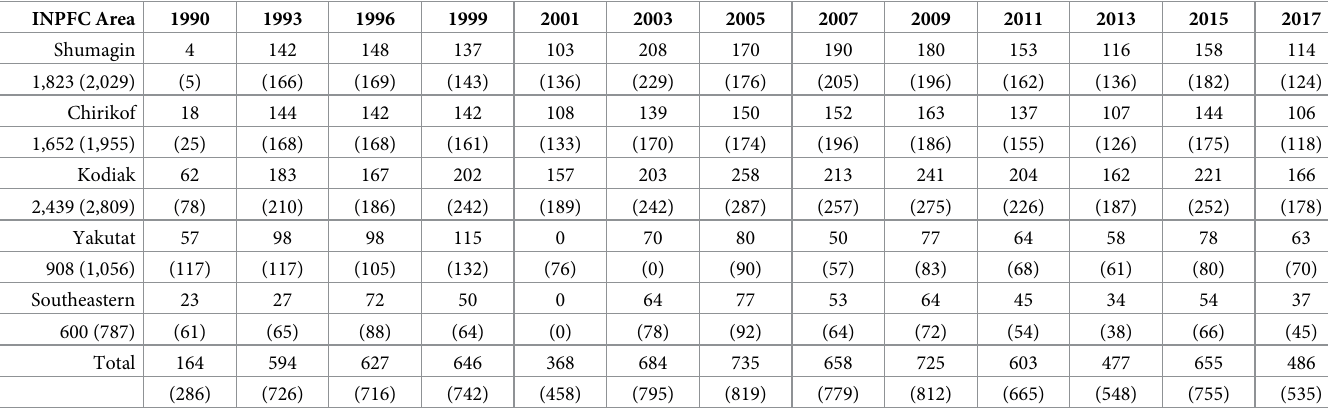
Table 2. Number of tows that captured at least one Arrowtooth Flounder (n = 7,422) measuring 30 to 69 cm fork length. INPFC Area